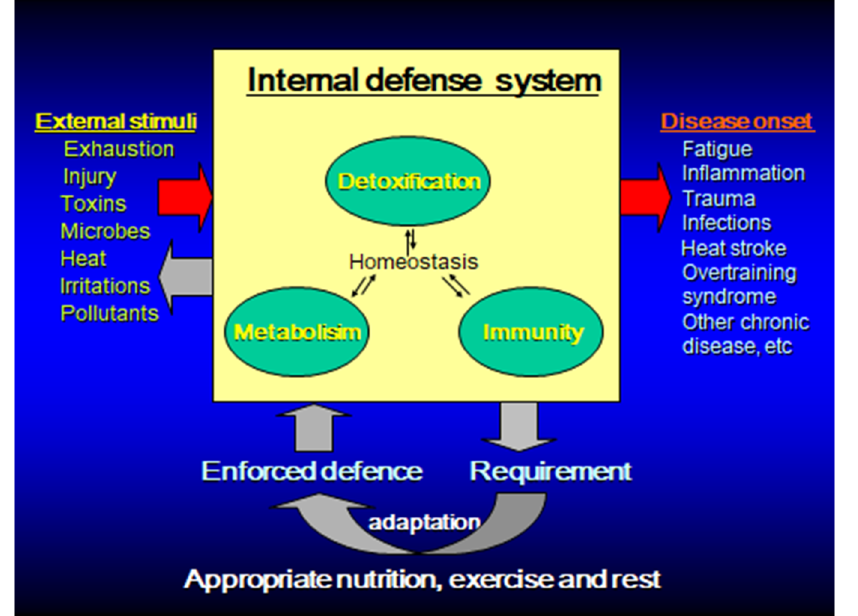
Figure 1. Homeostasis enforcement model for disease prevention through functional foods/supple- ments, exercise and rest by enhancing body’s innate defense